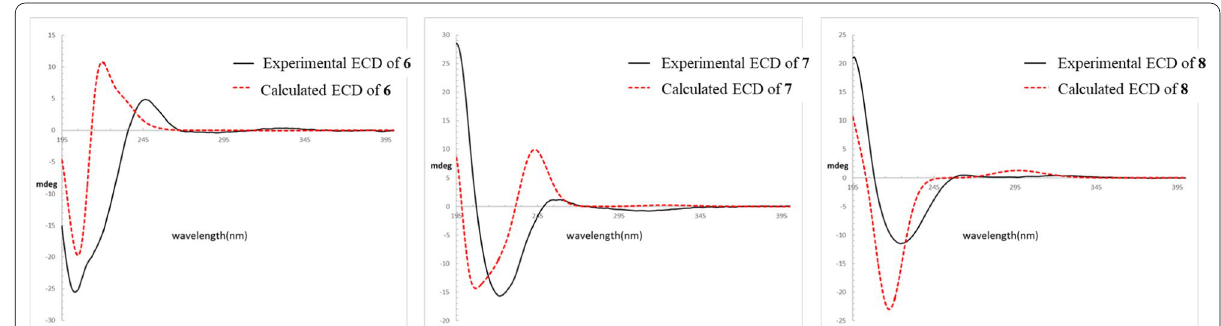
Fig. 5 Experimental and calculated ECD spectra of compounds